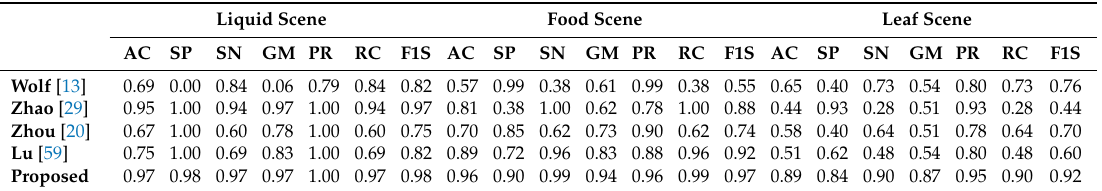
Table 3. Comparison of performances of BS methods for three scenes in the MSPI dataset.